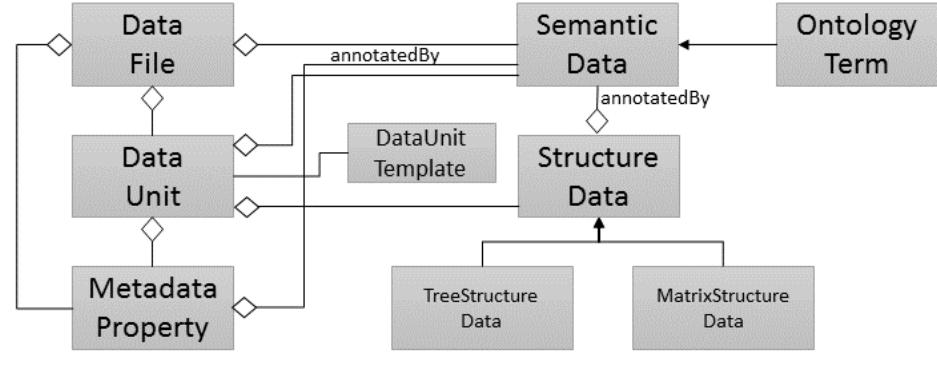
Figure 3. Conceptual View of the